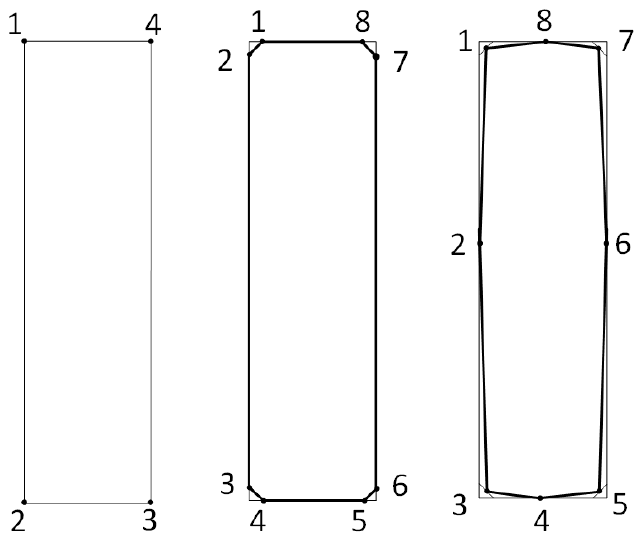
Figure 6. Schematic diagram of isosceles triangle optimization.